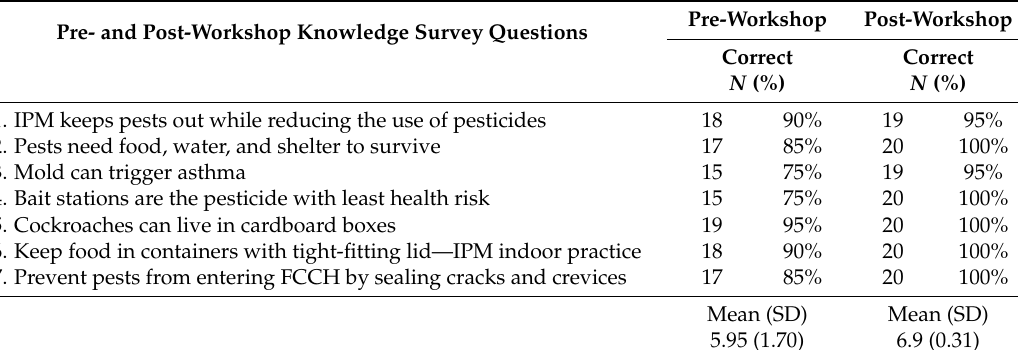
Table 4. IPM Workshop Knowledge Survey Results, N =